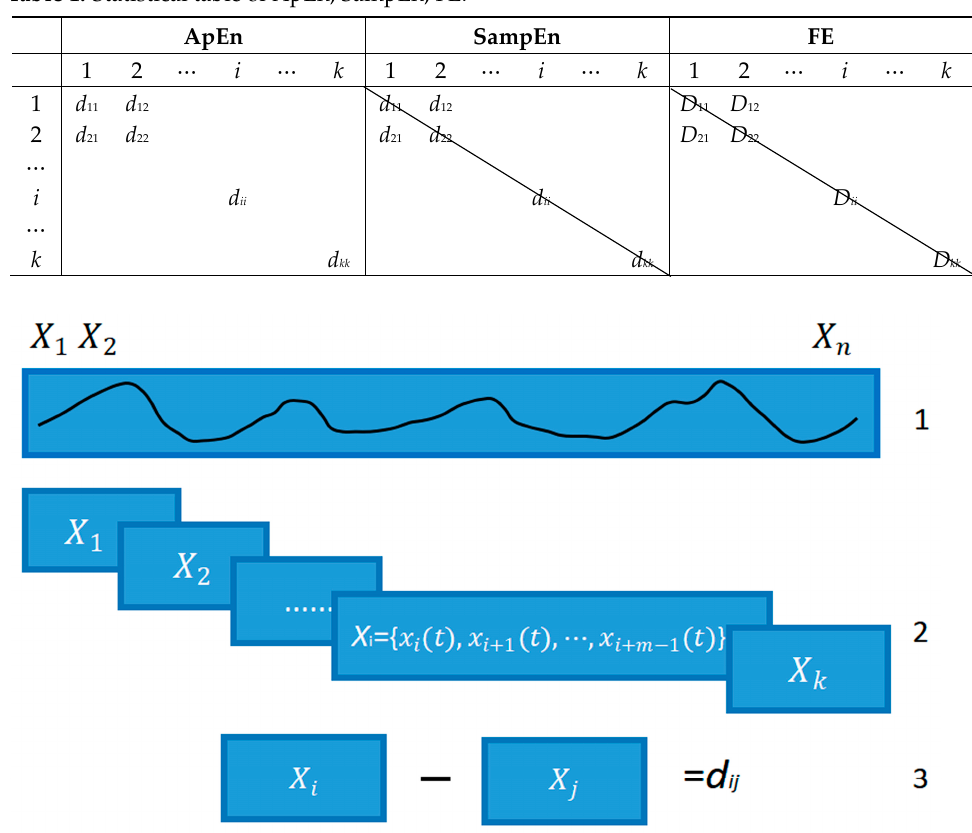
Figure 3. Calculation process of entropy value. Table 1. Statistical table of ApEn, SampEn, FE. ApEn SampEn FE